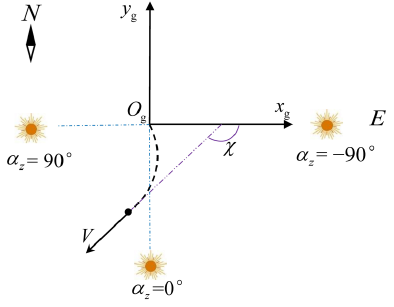
Figure 6. Definition of solar azimuth.